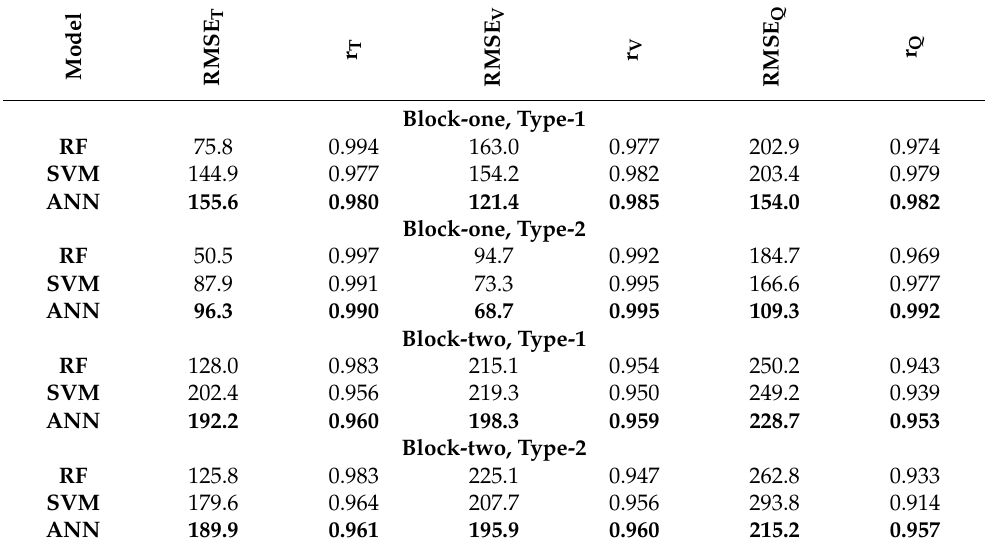
Table 3. Adjustments obtained for each selected ML approach developed to model the MGSI (Block- one) and to predict the MGSI one month ahead (Block-two) according to each input variable’s configuration (Type). The best models (in terms of RMSE in the validation phase) within each Block and Type are indicated in bold. RMSE corresponds with the root mean square error, r corresponds with the correlation coefficient and subscripts T, V and Q correspond to the phases; training, validation and querying, respectively. Adapted and data from Puga-Gil (2022)